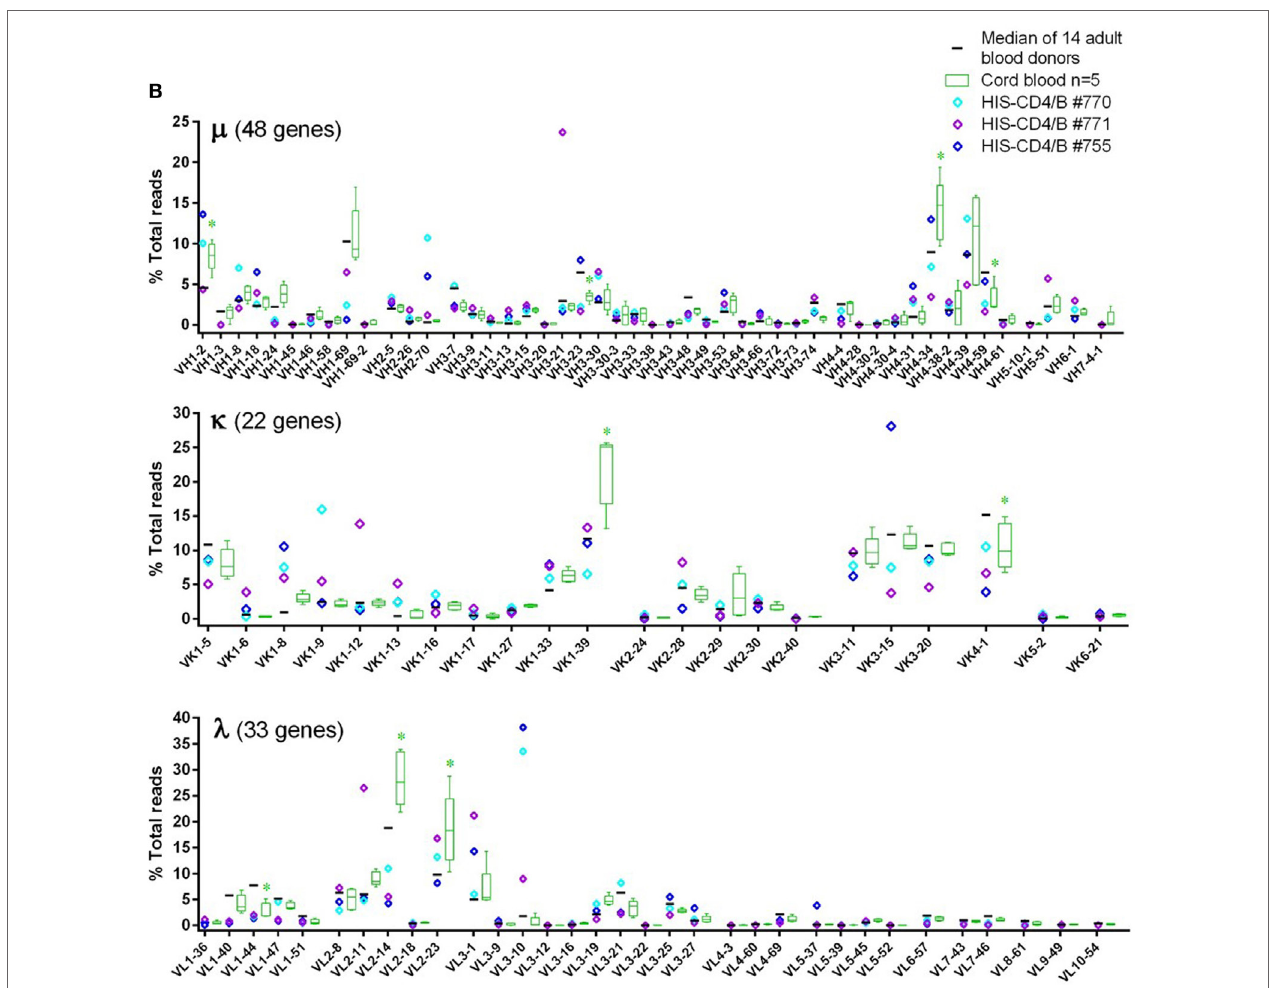
FigUre 2 | Individual V-gene usage of the μ , γ , α , κ , and λ chains in adult blood donor PBMCs, HIV-1 + PBMCs, cord blood, and HIS-CD4/B mice. Each panel shows a heavy or light chain as indicated. The y -axis shows the frequency of sequence reads assigned to the individual V-genes specified on the x -axis. (a) Comparisons between blood donors (gray) and HIV-1 + donors (red). Note that α data were only available for three HIV-1 + donors. The box plots indicate the medians, interquartile, and 10–90% ranges. (B) Comparisons among adult blood donors (black bars), cord blood (green boxes), and three HIS-CD4/B mice (diamonds). Asterisks depict statistical significant and > 3% differences in the indicated genes between the indicated groups and the adult blood